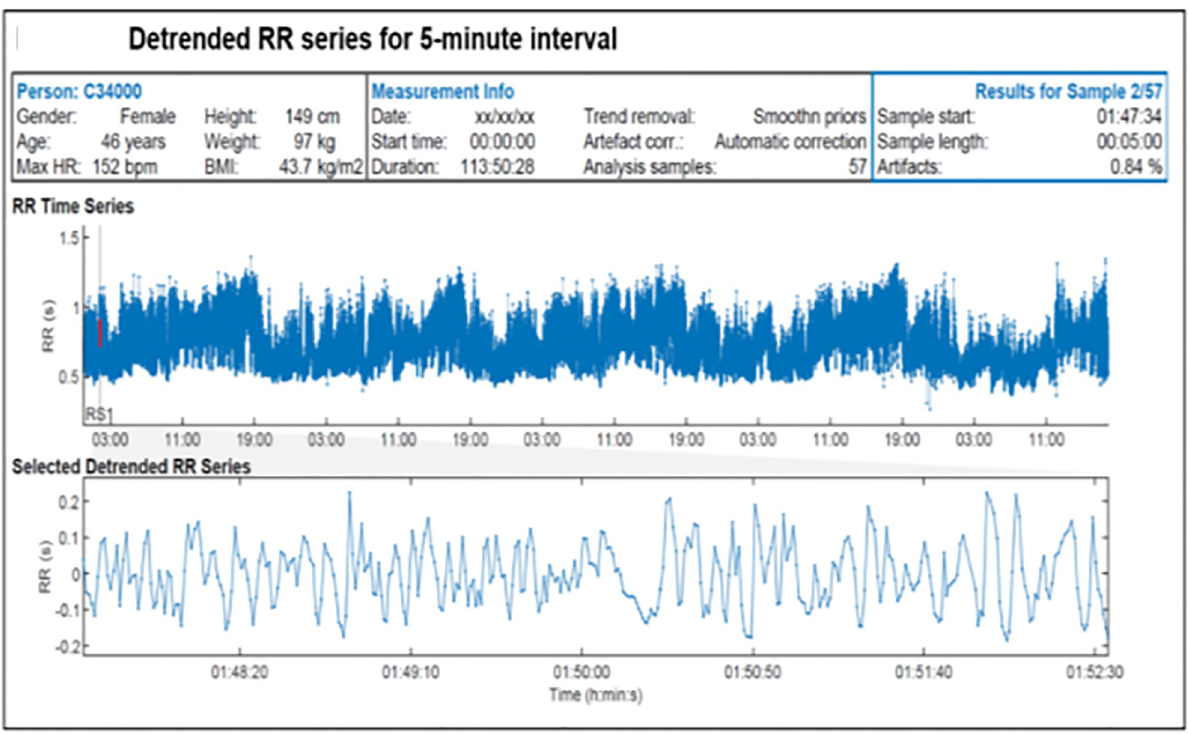
Fig 1. Inter-beat-interval (RR) series generated in Kubios HRV Premium